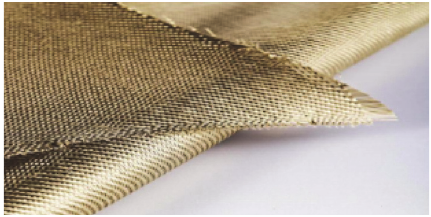
Figure 4: Basalt fiber sheet.